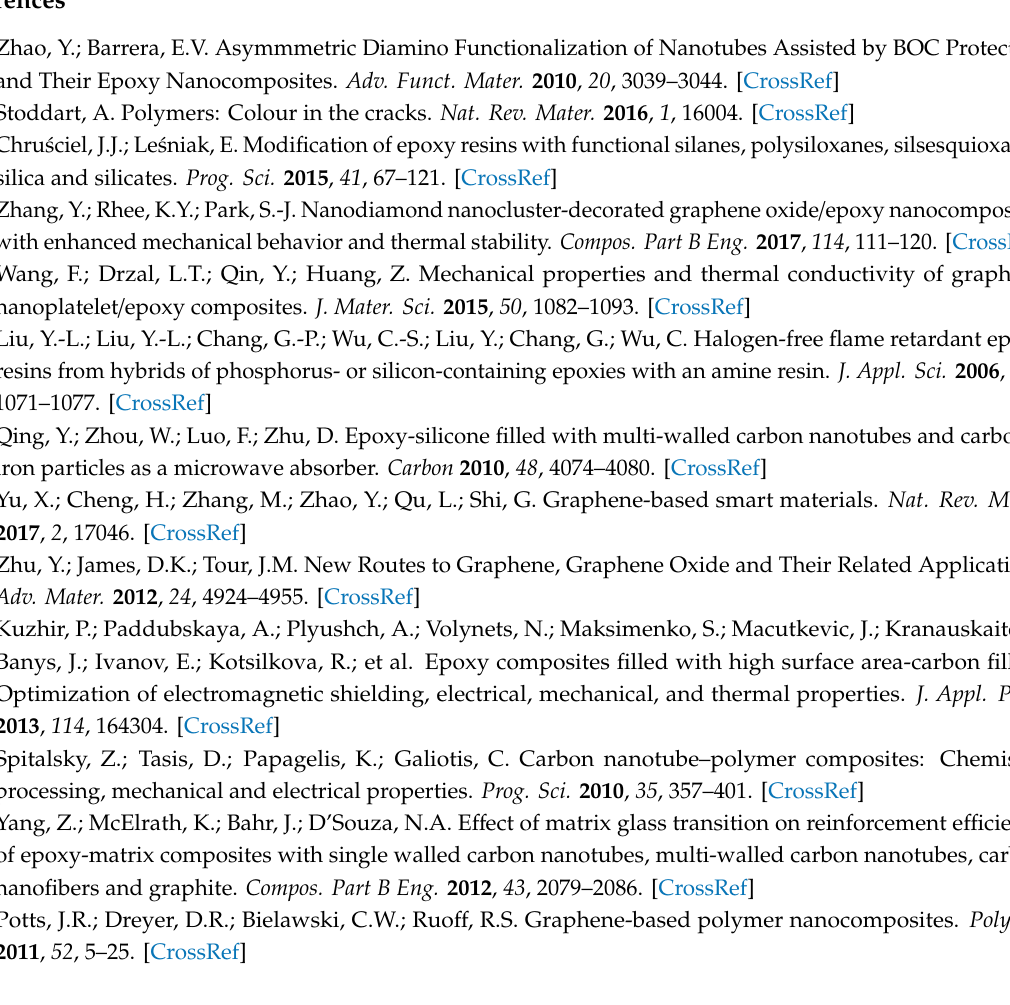
Figure S1: Chemical structure of HMTA, N-BPH and DGEBA, Figure S2: XPS survey scan of GO and HMTA-GO, Figure S3. SEM images of (a) GO and (b) HMTA-GO, Figure S4. XRD spectrum of (a) Neat epoxy (b) GO 0.04 (c) GO 0.06 (d) GO 0.08 (e) GO 0.1 (f) GO 0.2 (g)HMTA-GO 0.04 (h) HMTA-GO 0.06 (i) HMTA-GO 0.08 (j) HMTA-GO 0.1 (k) HMTA-GO 0.2, Figure S5. Schematic illustration for calculation of A* and K*, Figure S6. Plot of ln(ln(1 / 1- α )) versus θ , and Figure S7 DSC curves for epoxy composites. Table S1: Analysis of the deconvoluted C1s peaks obtained from XPS and the FWHM of the di ff erent C1s peaks as well as the relative area percentages for GO and HMTA-GO, Table S2: Atomic percentage of C, O and N for GO and HMTA-GO, Table S3: Elemental composition of N-PBH, Table S4. Exothermic peak temperatures of epoxy composites obtained by